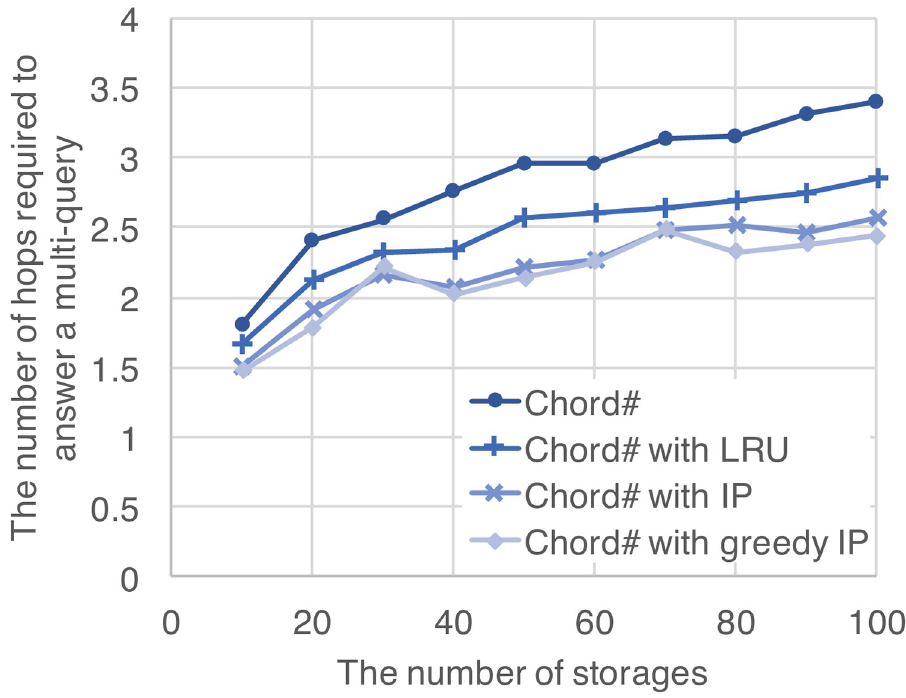
Fig 7. Reduction of the number of hops required to answer a multi-query by the proposed